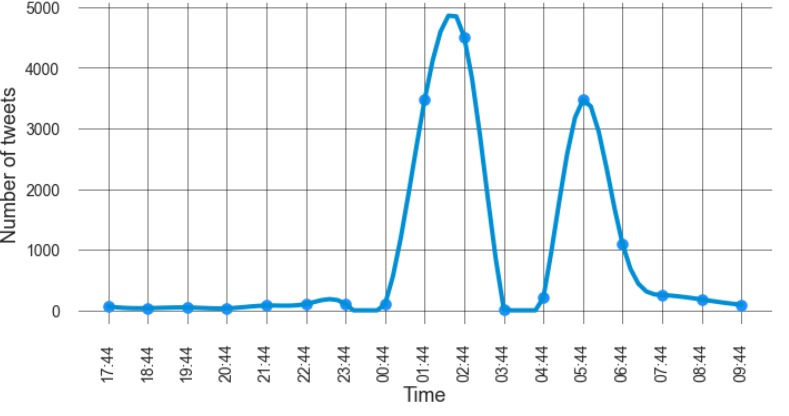
Figure 1. Distribution of tweets per hour. Tweets were collected from 6 August 2015 at 17:44:53 to 7 August 2015 at